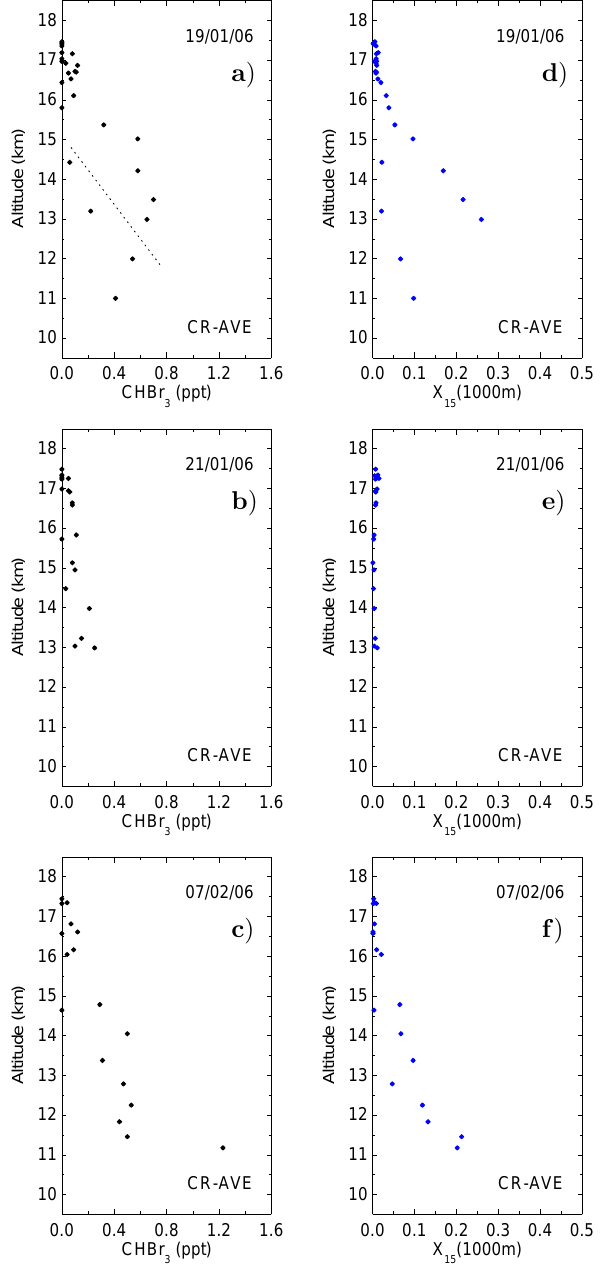
Fig. 11. A comparison between CHBr 3 observed on selected days of CR-AVE (a–c) and NAME calculated profiles of a tracer with 15 day e-folding lifetime for the same sample locations and times (d–f) . The dashed line in (a) separates observations collected on two different descents through the TTL; lower mixing ratios were found at ∼ 10 ◦ N, and higher mixing ratios found near the